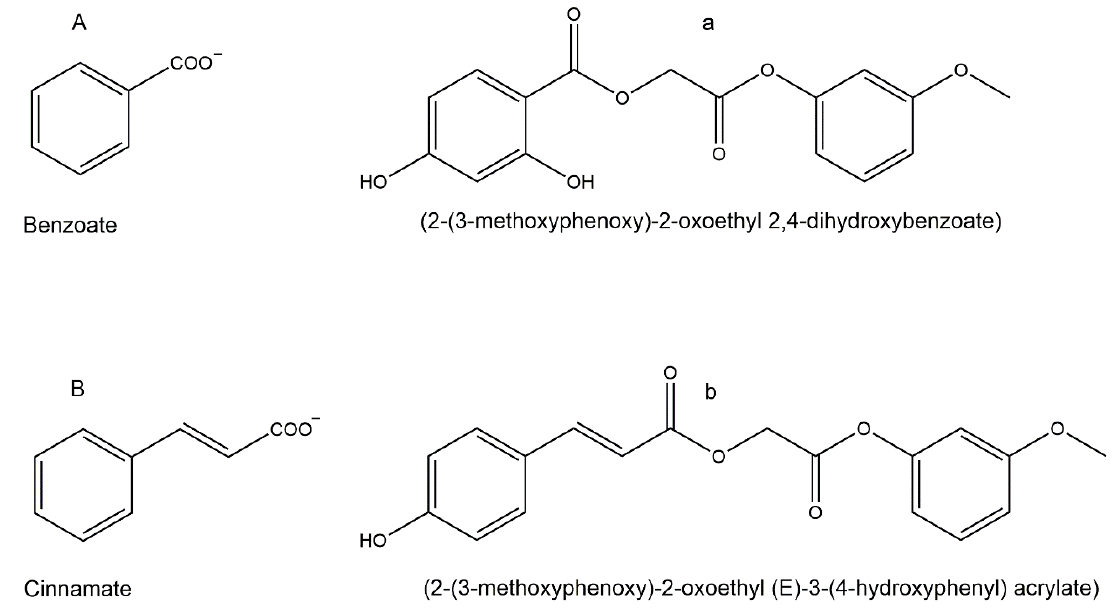
Figure 2. Chemical structures: Benzoate ( A ), cinnamate ( B ), and their derivatives ( a , b ).